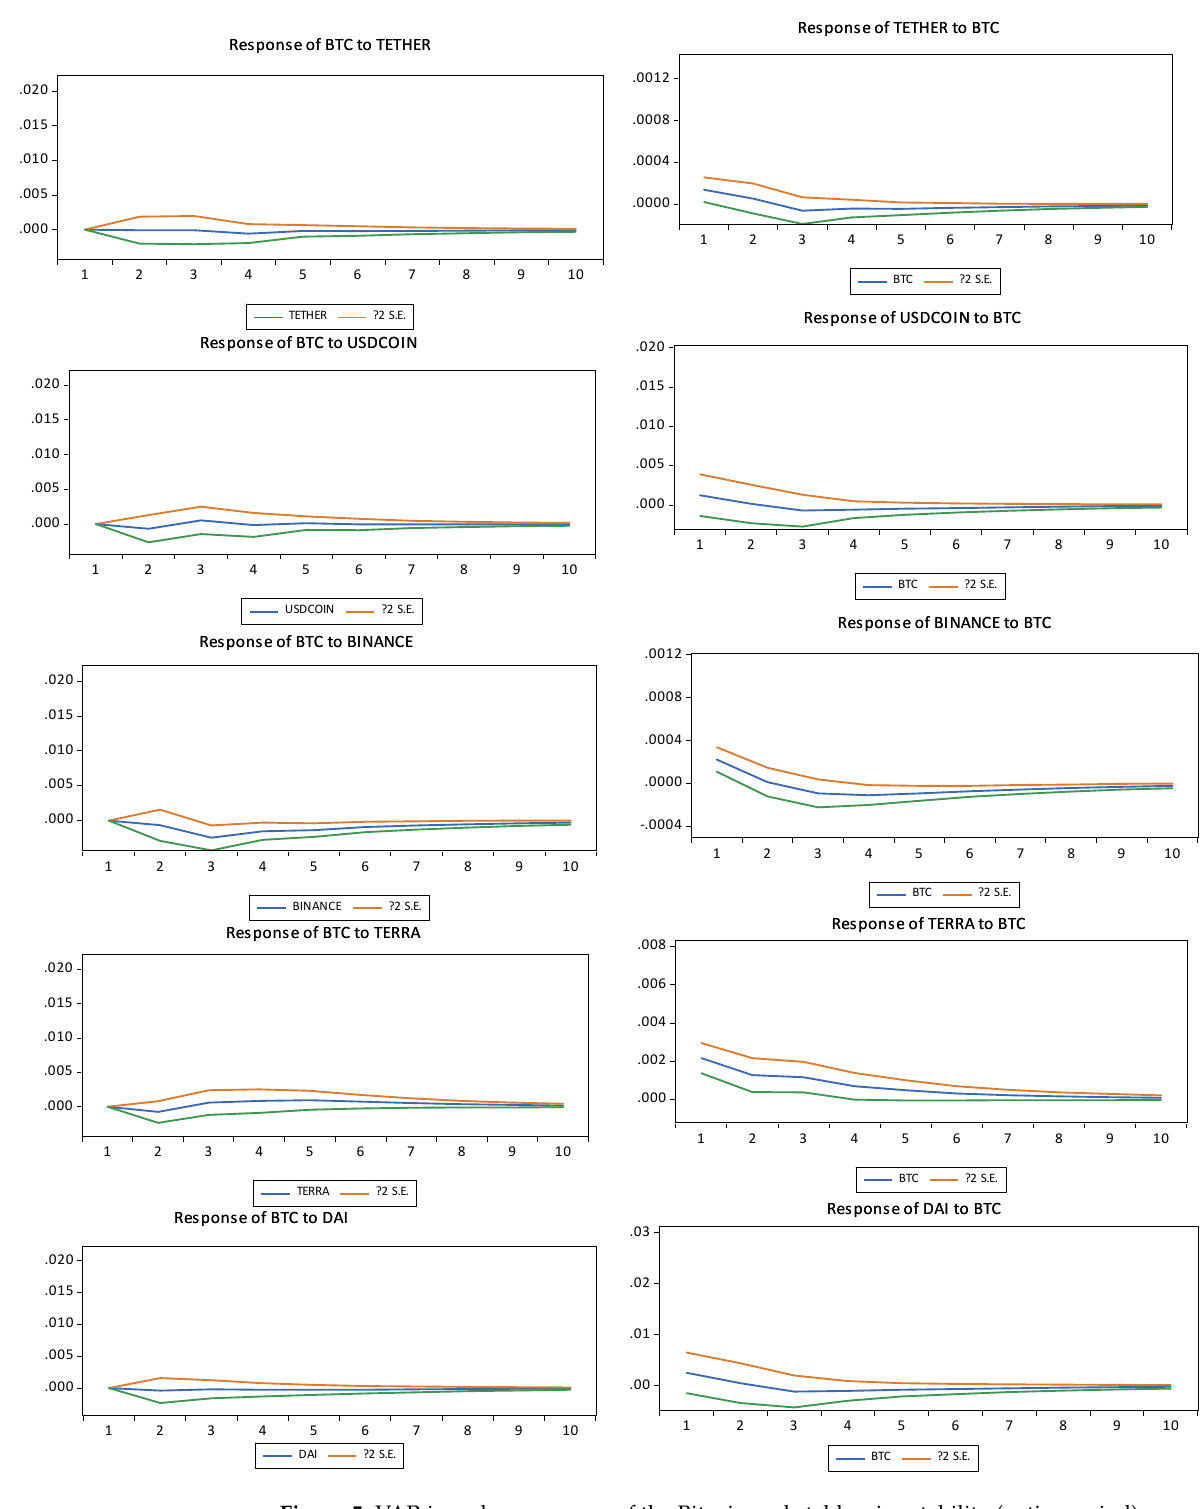
Figure 5. VAR impulse responses of the Bitcoin and stablecoins stability (entire period).